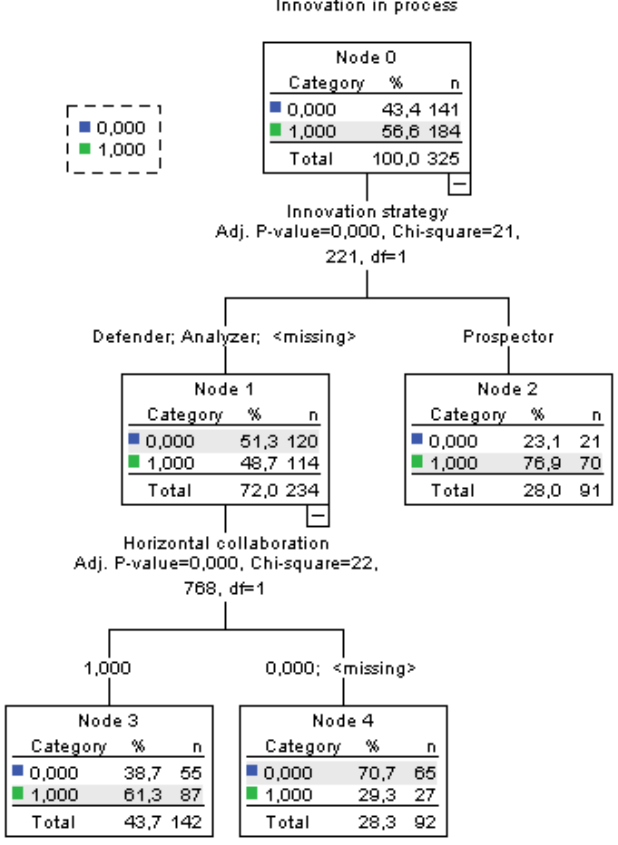
Figure 3. Determinants of innovation in